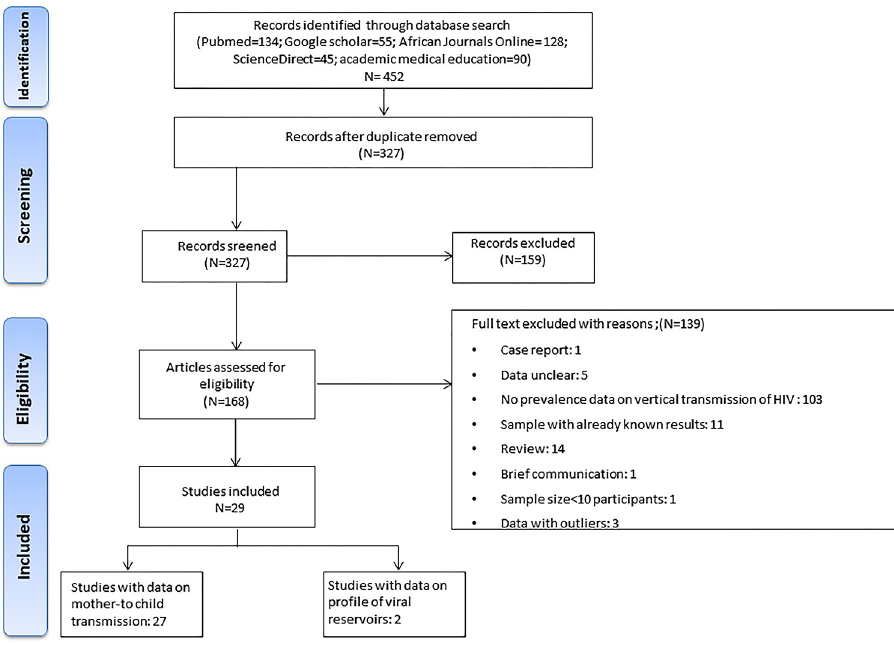
Fig 1. Flow chart of the study selection